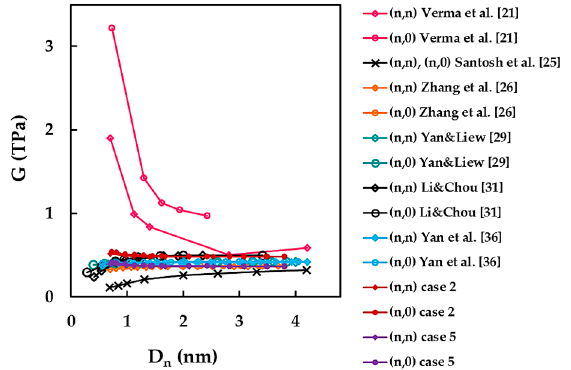
Figure 14. A comparison of the current shear modulus results with those reported in the literature as a function of the nanotube diameter, D n .